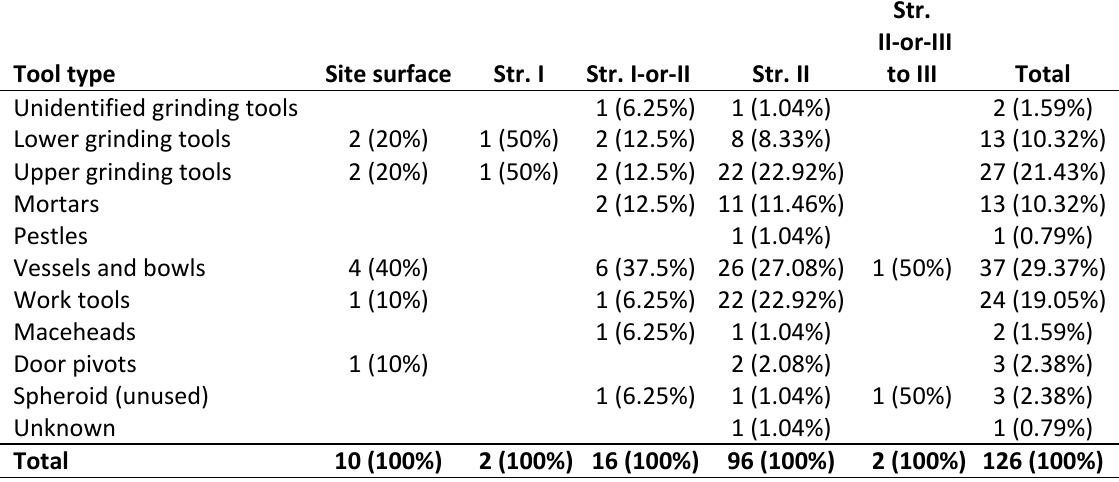
Table 2: Distribution of ground stone tool types across strata in Fazael 2. Abbreviations: Str. - strata.